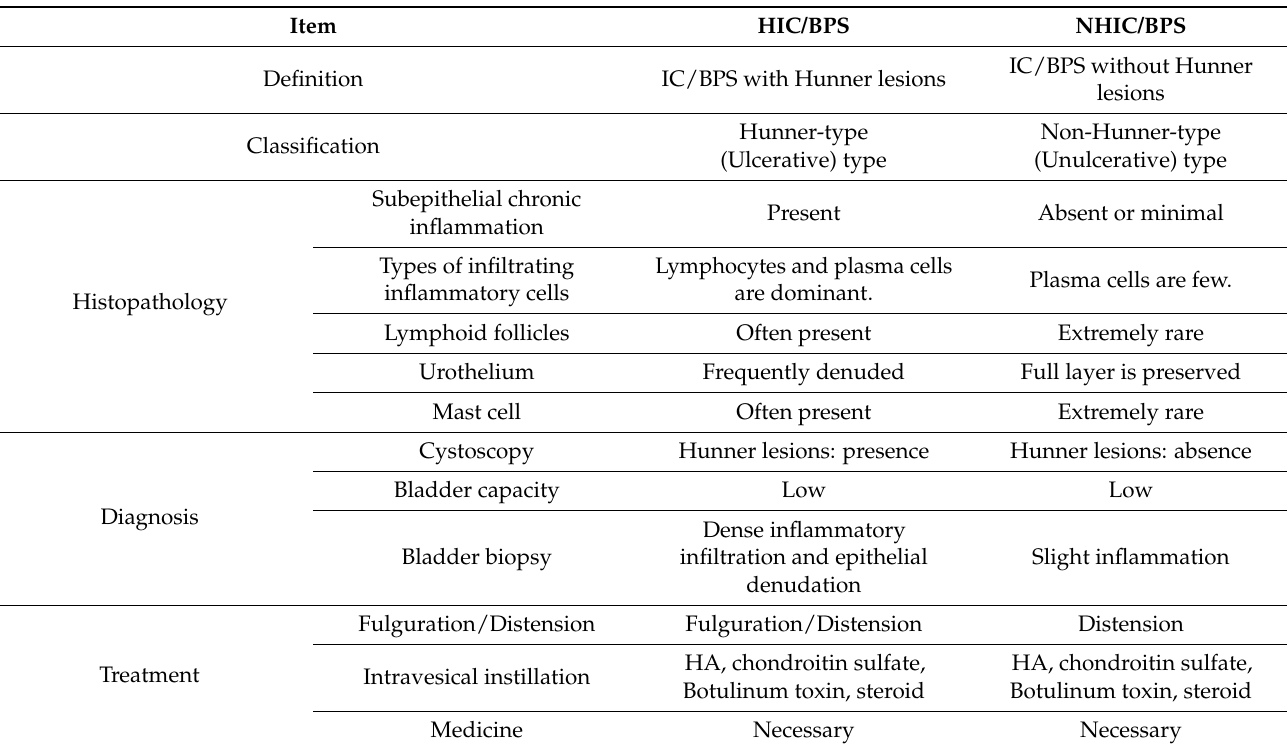
Table 1. Definition, classification, histology, diagnosis, and treatment show differences between HIC/BPS and